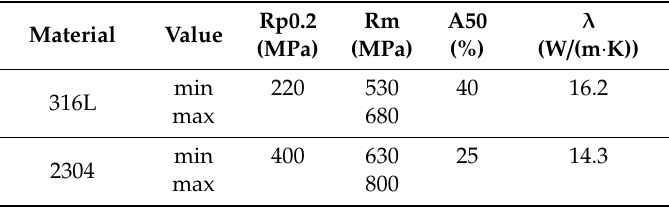
Table 2. Mechanical and physical properties of base materials.